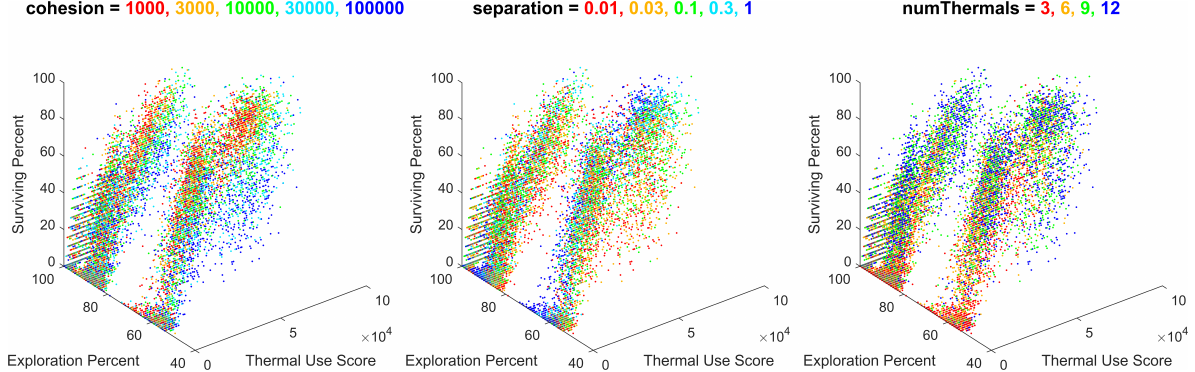
Figure 17. All batch simulation data plotted for thermal use, exploration percentage, and survival percentage, colored for cohesion values of 1000, 3000, 10,000, 30,000, and 100,000; separation values of 0.01, 0.03, 0.1, 0.3, and 1; and number of thermals of 3, 6, 9, and 12. Note the color gradients within the plots, resulting from each unique value of cohesion, separation, and number of